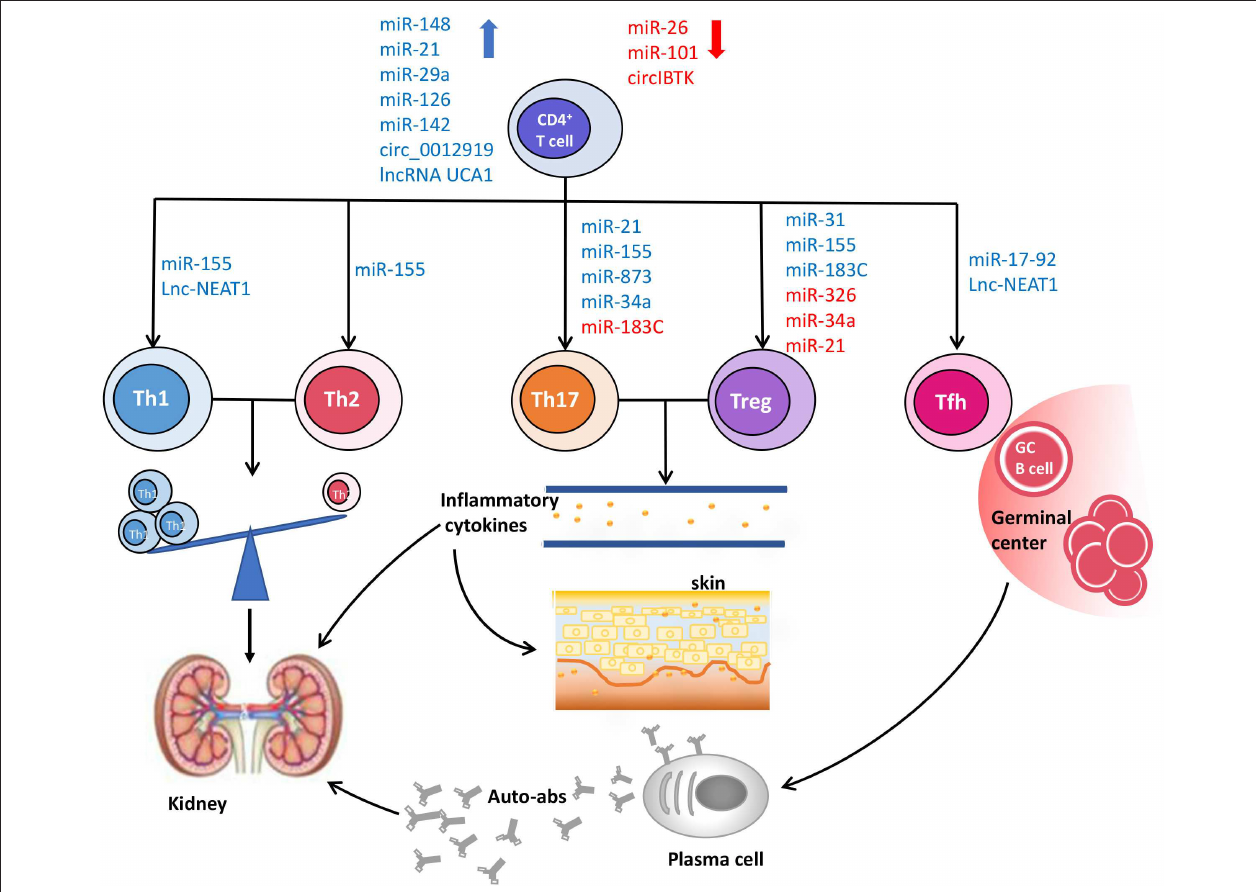
FIGURE 1 | The roles of ncRNAs in CD4 + T cell dysfunction and pathogenesis of SLE. The aberrant expression of ncRNAs disturbs the normal biological processes of CD4 + T cells, and then leads to the phenotypic and functional changes of CD4 + T cells, including the imbalance of Th1/Th2, increased proportions of pro-inflammatory Th17 cells and Tfh cells, as well as deficient frequency and function of Treg cells, which contribute to the occurrence and development of